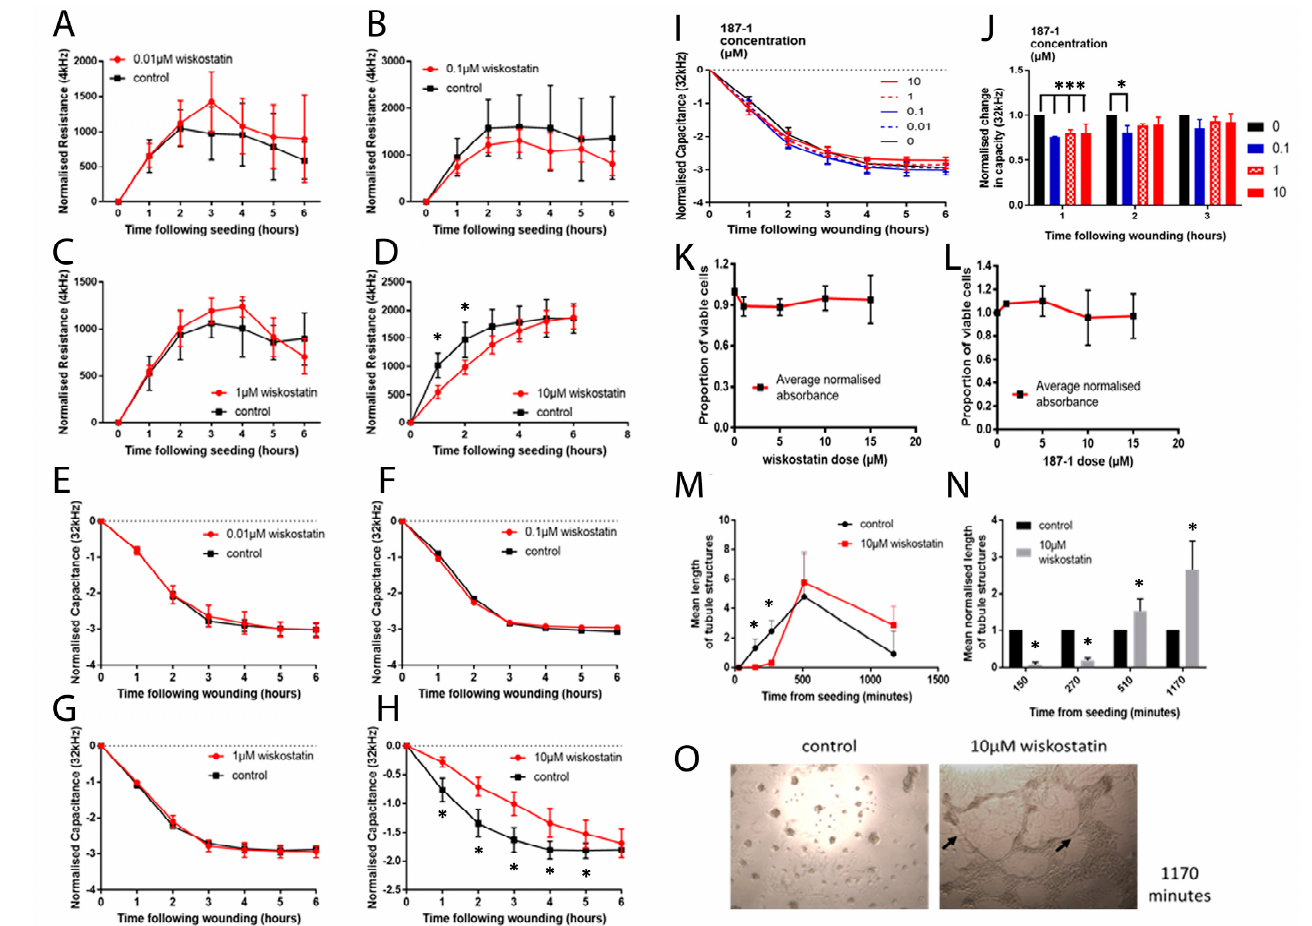
Figure 4. The effect of wiskostatin on the HECV cell behaviour. HECV cells were treated with wiskostatin at 0.01, 0.1, 1 and 10 µ M concentrations ( A – D ). HECV cells were treated with wiskostatin at 0.01, 0.1, 1 and 10 µ M concentrations ( E – H ). HECV cells were treated with 187-1 at 0, 0.1, 1 and 10 µ M concentrations and monitored for 6 h following an electrical wounding event ( I ). The mean changes in capacity in the 187-1-treated wells are also shown ( J ). Following 48 h with wiskostatin and 187-1 ( K , L ). Mean lengths of the tubule structures of 10 µ M wiskostatin-treated and control HECV cells ( M ). Tubule structure lengths at time points of 150–1170 min ( N , O ) in terms of the number of pixels. * indicates statistical significance (* p < 0.05, *** p <